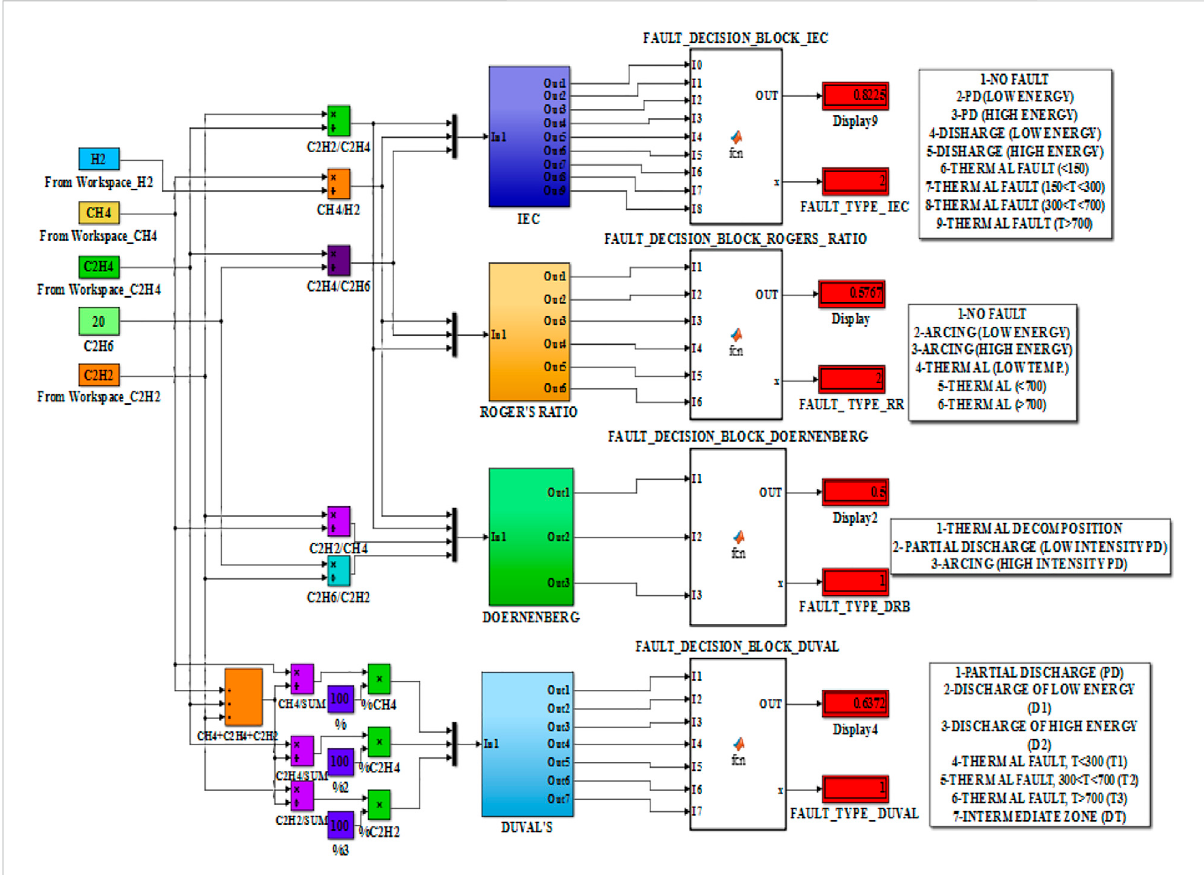
FIGURE 10 ANFIS model for online transformer incipient fault